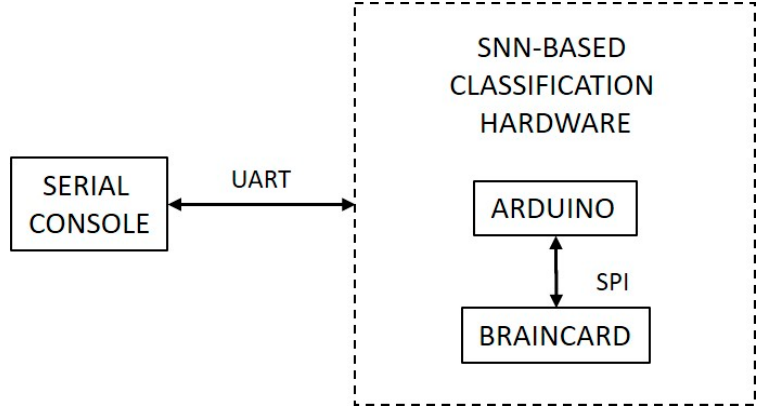
Figure 6. Block diagram of the hardware setup for the SNN classifier and its interfacing .